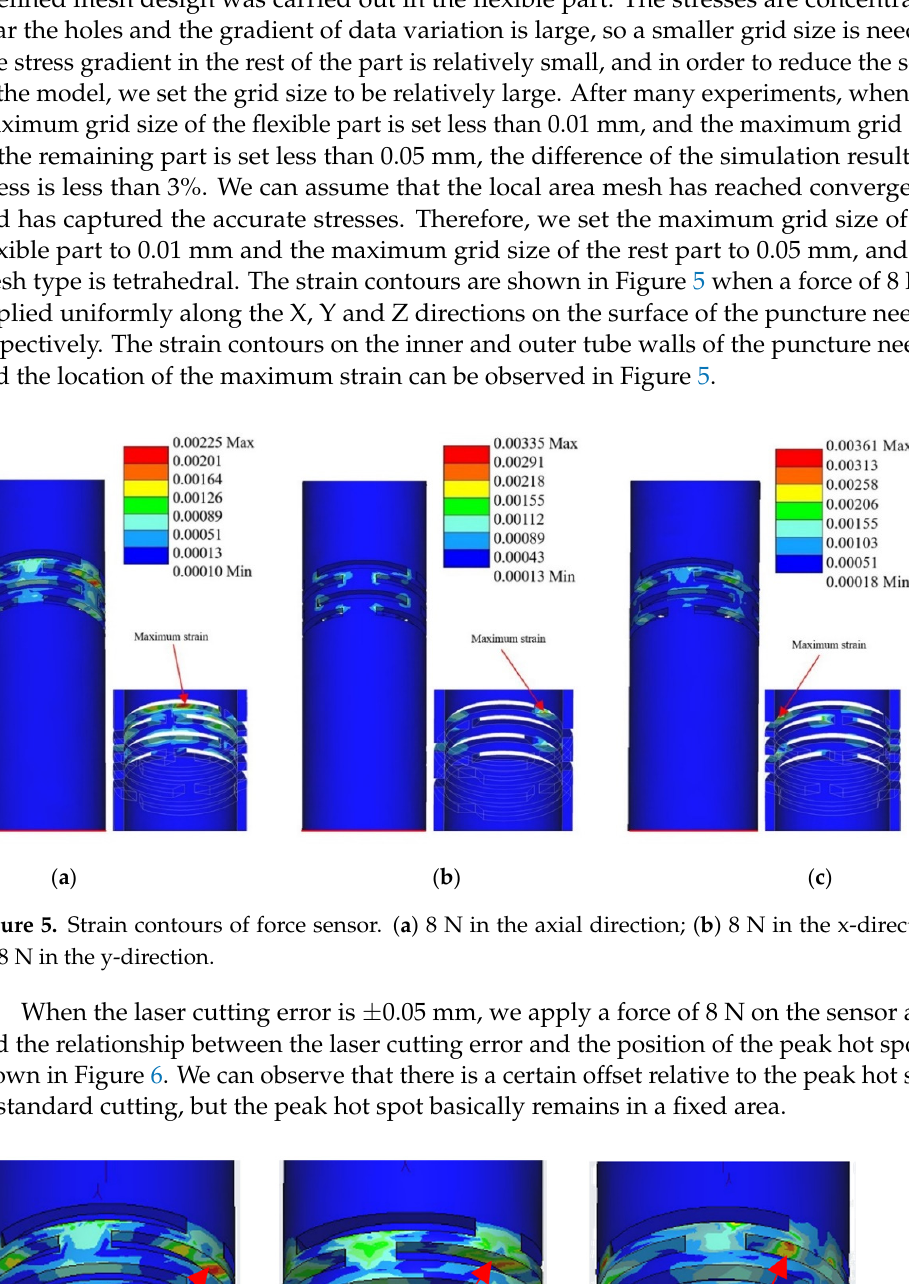
Figure 4. Three slotted designs for sensors. ( a ) Coil spring design; ( b ) cantilever beam design; ( c ) parallel slot design.